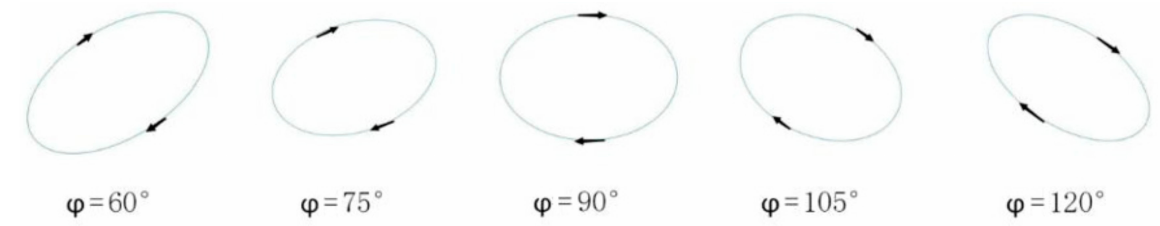
Figure 2. Elliptical motion trajectories under different phase